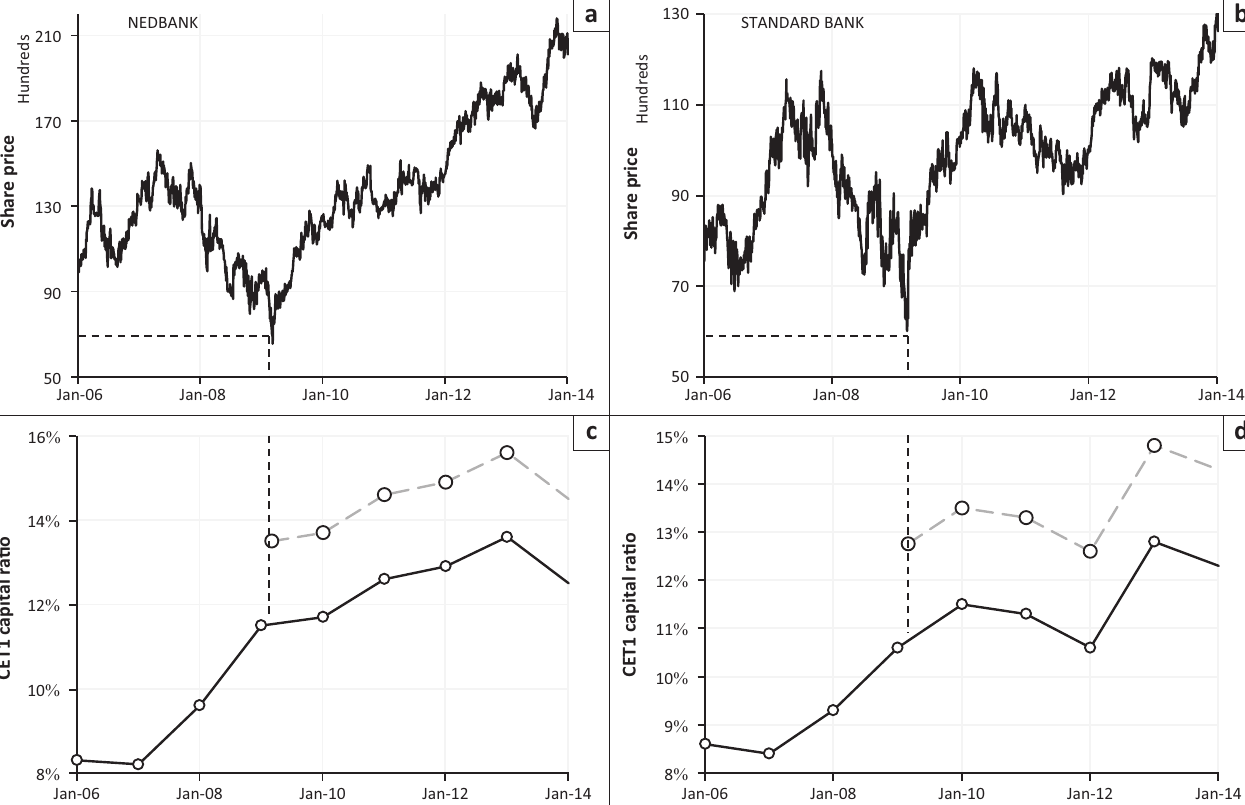
FIGURE 9: Share prices of Nedbank (a) and Standard Bank (b) with common equity tier 1 ratios (c) prior to- and (d) after contingent convertible conversions.